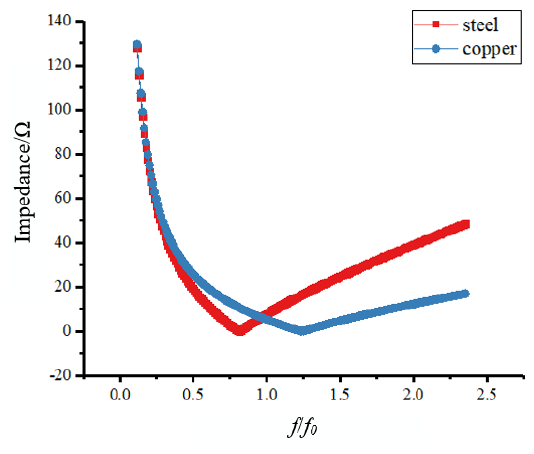
Figure 8. Frequency sweep curve.